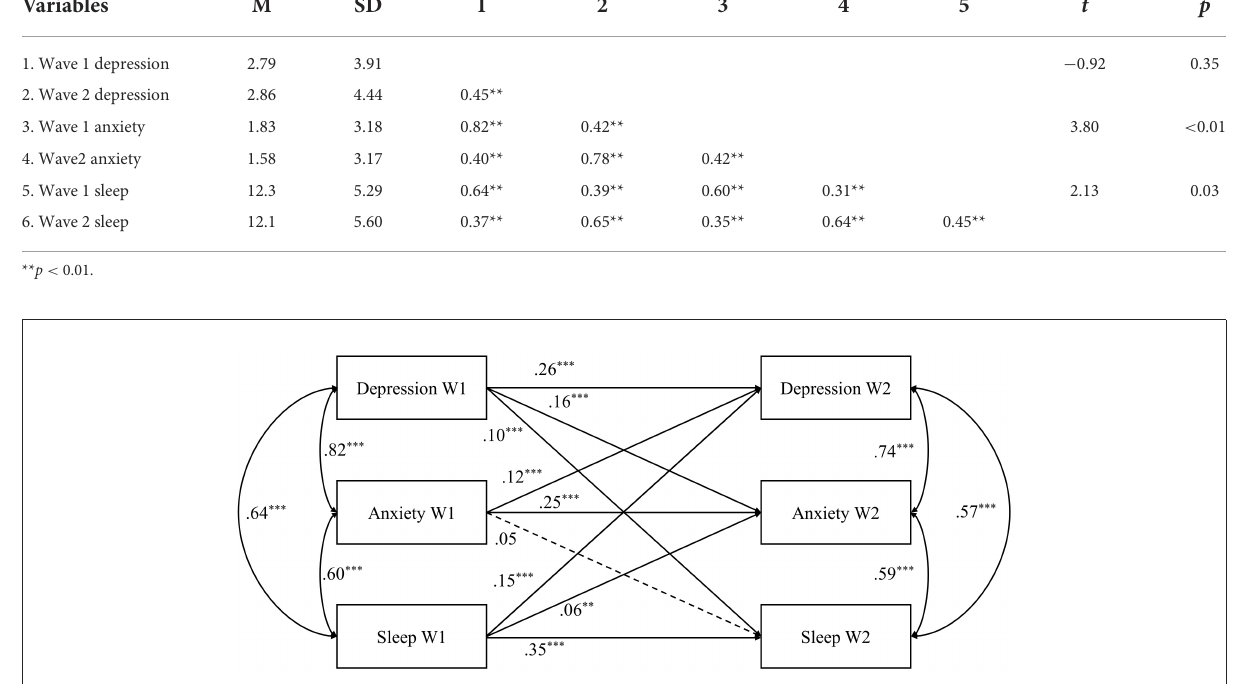
FIGURE1 The standardized cross-lagged model between depression, anxiety, and sleep disturbances. The residuals were not shown; ** p < 0.01, *** p < 0.001.